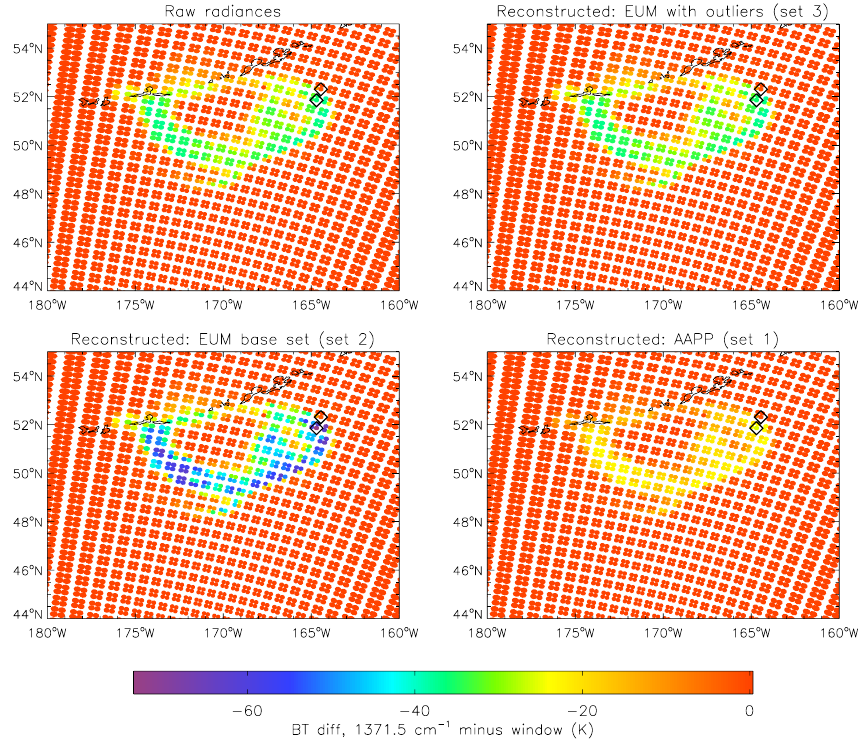
Fig. 5. SO 2 signal associated with the Kasatochi volcano eruption on 8 August 2008, 21:23 MetOp overpass. The brightness temperature at 1371.5 and 1371.75cm − 1 has been subtracted from the brightness temperature in adjacent window channels. Note the anomalously large signal in the reconstructed radiances from the set 2 eigenvectors. The volcano is located at 52.18 ◦ N, 175.51 ◦ W. The spots selected for display in Fig. 6 are marked by black diamonds.